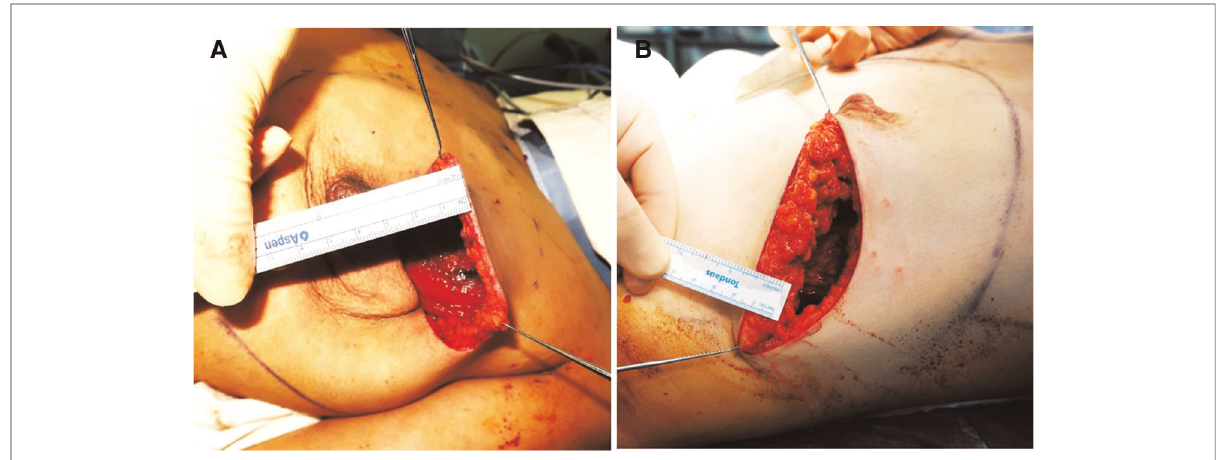
FIGURE 2 Images show the intraoperative thickness of mastectomy fl aps: ( A ) 42 years old patient with left breast cancer presented with c-NSM (BMI:23.61 fl ap thickness=0.5 cm); ( B ) 39 years old patient diagnosed with right breast cancer is shown after m-NSM (BMI:25.21; fl ap thickness=1.5 cm). c-NSM, conventional nipple-sparing mastectomy; m-NSM, modi fi ed nipple-sparing mastectomy.